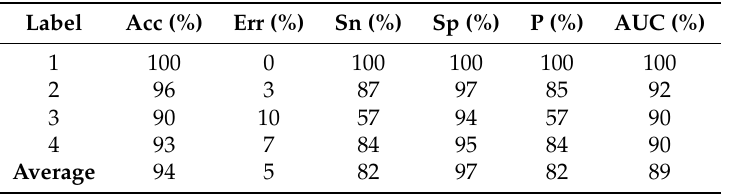
Table 4. Performance values with